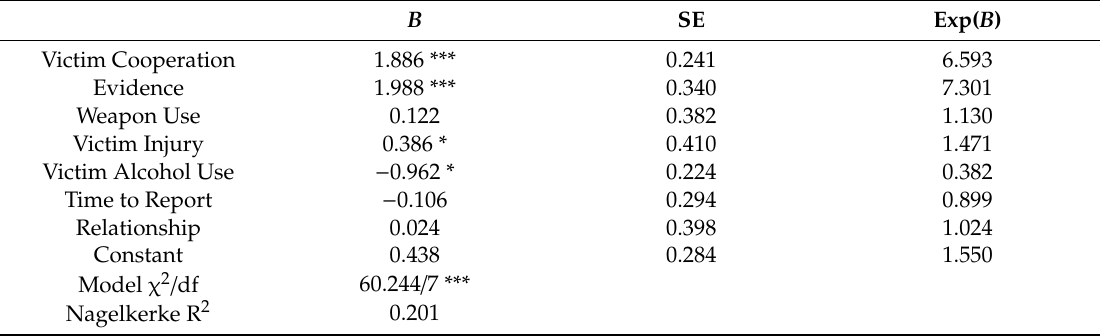
Table 3. Logistic regression for police decision to forward cases to